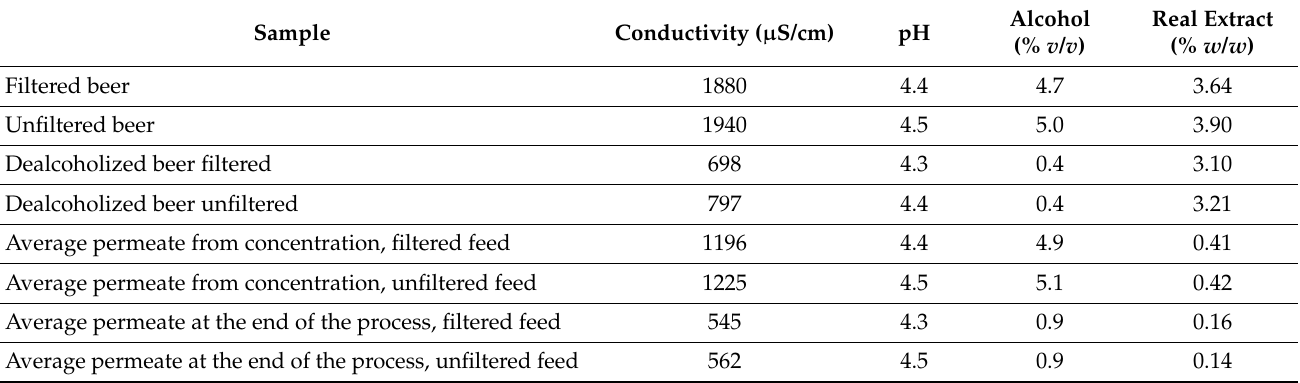
Table 1. Conductivity, pH, alcohol, and real extract content of original and dealcoholized beer and permeate samples.